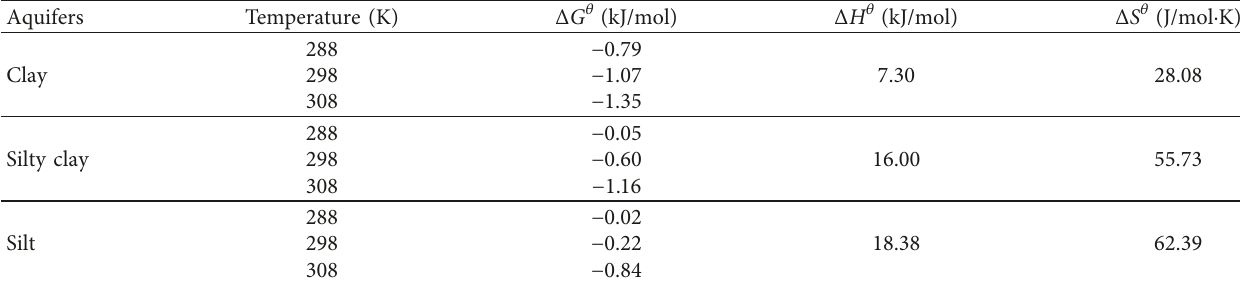
Table 3: Thermodynamic parameters for Cr(VI) adsorption in different aquifers.